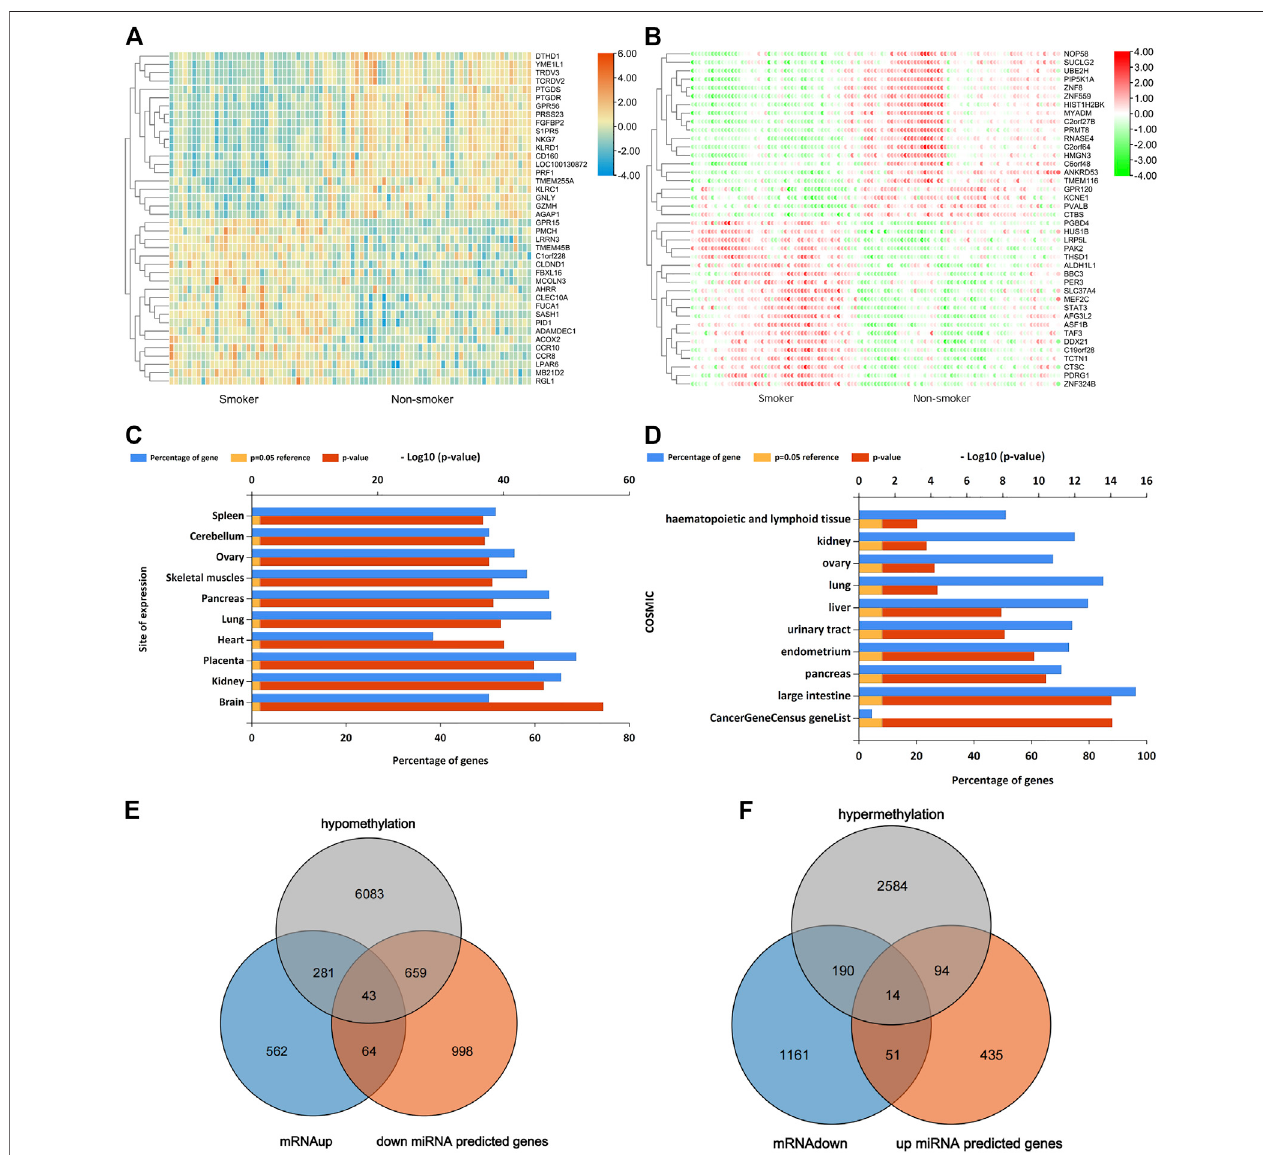
FIGURE 2 | (A) , Top 40 DEGs (20 up-regulated genes and 20 down-regulated genes) of GSE87072. (B) , Top 40 DMGs (20 hypermethylation genes and 20 hypomethylation genes) of GSE53045. Red indicates that the expression of genes is relatively up-regulated, blue or green indicated that the expression of genes